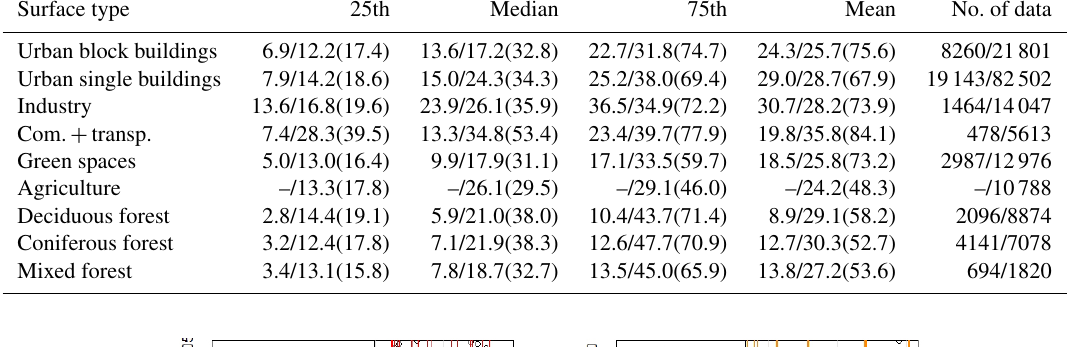
Table 7. Particle mass (PM 10 ) burden characteristics (bicycle/van background (van all) measurements) at different land use types in µgm − 3 . “–” indicates areas which have not been tested by the method. This table provides the 25th, 50th and 75th percentiles as well as the mean and the number of available data points.